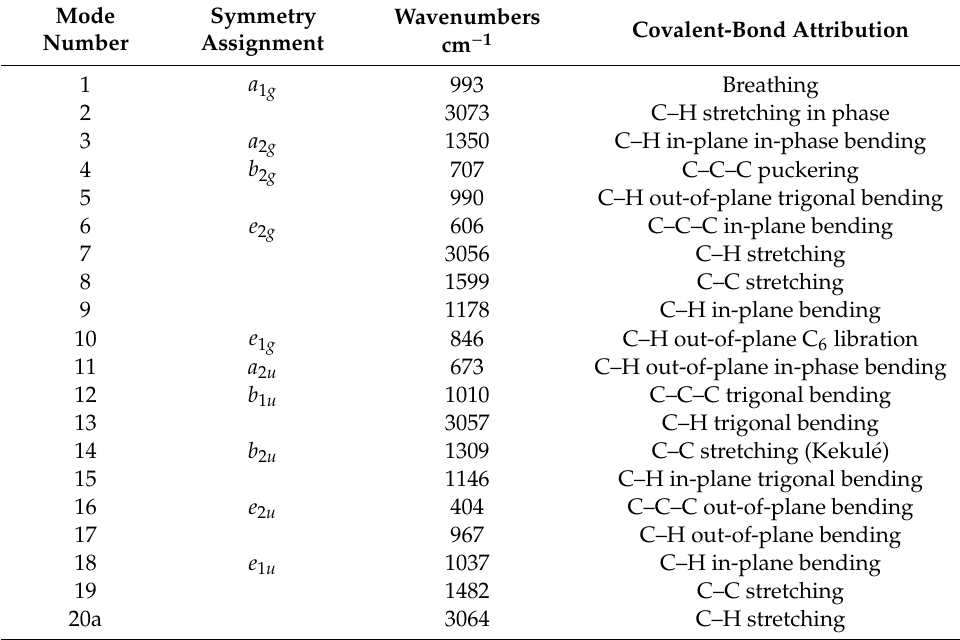
Table 3. Vibrational modes of benzene molecule (composed of data from